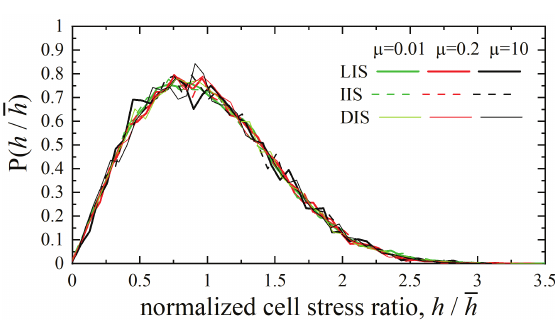
Fig. 6. PDF of cell stress ratio